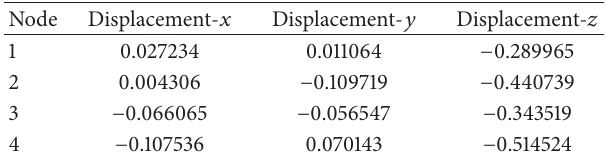
Table 1: The displacements (in m) at nodes 1, 2, 3, and 4 using the linear FEM for the first experiment. The displacements of nodes 5 to 8 for all axes are zero.